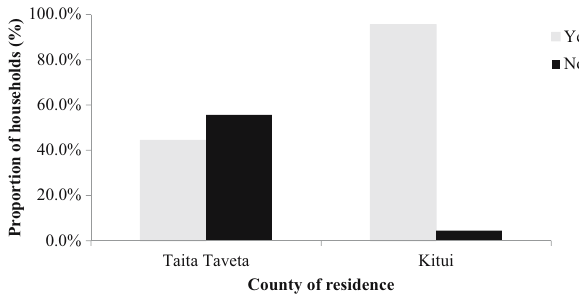
Figure 3: Prioritization of cowpea leaves as a farm produce based farm yields in the di ff erent counties. p < 0.001, df = 1 and χ 2 = 125.05.